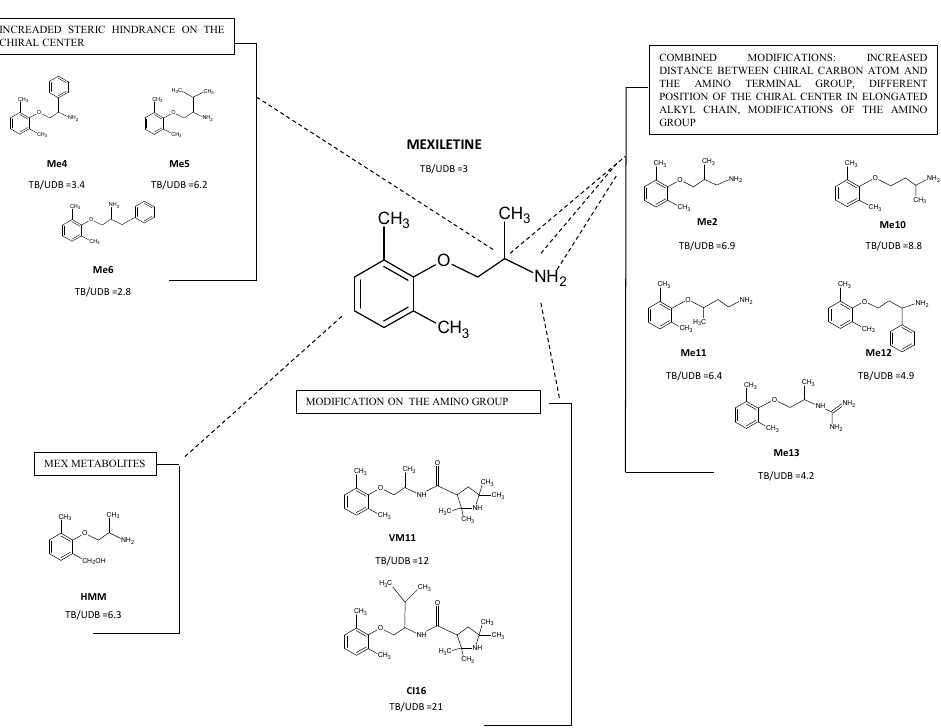
Figure 2. Chemical structure of Mexiletine and its newly synthesized analogs. The boxes show the most interesting compounds with the ratio between IC 50 values during tonic block (TB) and use-dependent block at the frequency of 10 hertz (UDB) (IC 50 TB/IC 50 UDB 10-Hz). The ratio is shown to allow an easier comparison of the use-dependent behavior of each compound [87].